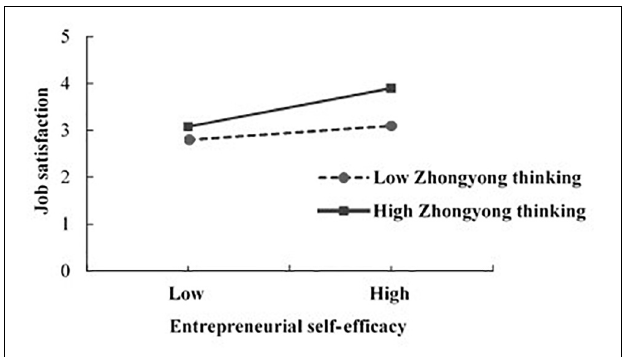
FIGURE 2 | Moderating role of Zhongyong thinking in the relationship between entrepreneurship self-efficacy and job